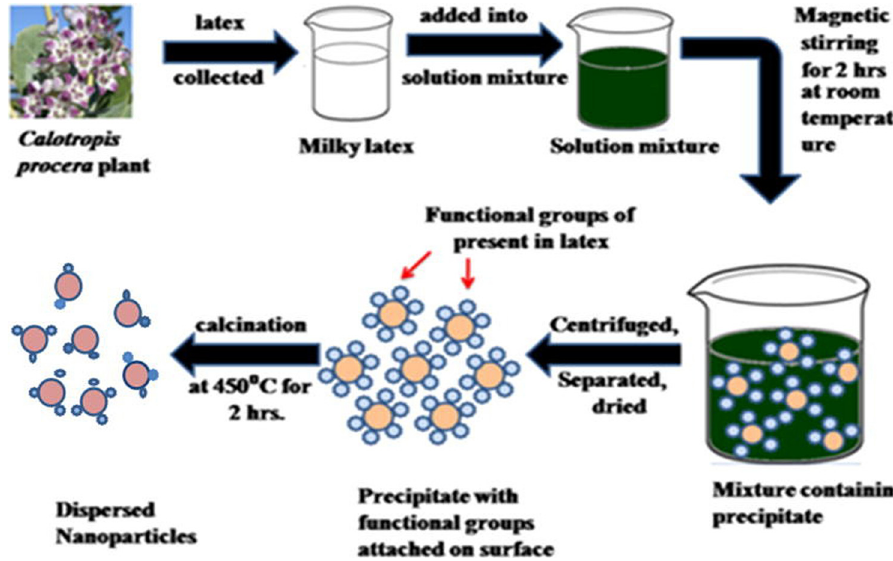
Figure 19: Synthesis steps of Co 3 O 4 NPs. Copied with permission from ref. [ 238 ] ; Elsevier,